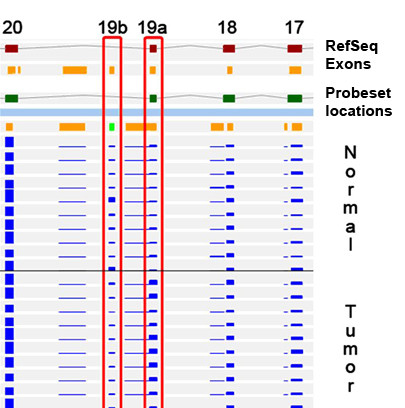
An example of probeset-level intensities from two mutually exclusive exons (19a and 19b) of ACTN1 in a genomic context. The probeset signals are normalized for each sample to the median signal for that sample across all the probesets in the view. This candidate splicing event was confirmed by RT-PCR. (BLIS viewer from Biotique.)